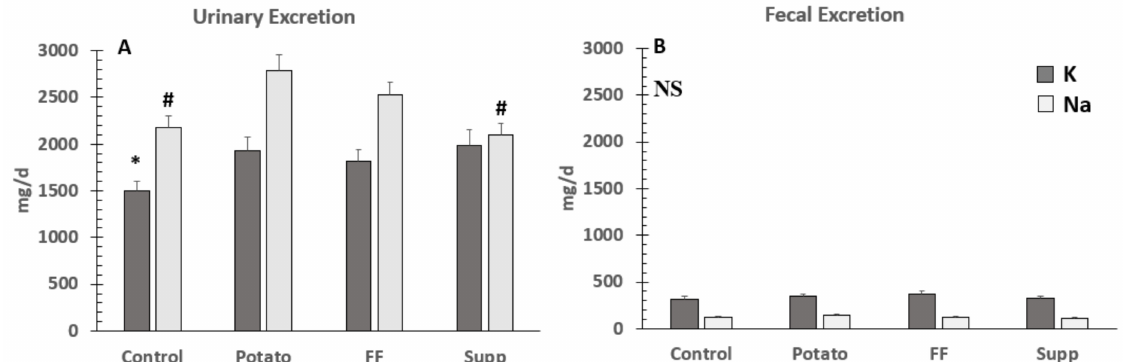
Figure 5. ( A ) Urinary (N = 28) and ( B ) Fecal (N = 20) excretion of potassium and sodium in hypertensive adults fed a typical potassium intake (control) and supplemented potassium through food (baked or boiled potatoes or French fries (FF)) or supplement. * denotes significant differences between control and potassium groups ( p < 0.05) for potassium retention. # denotes significant differences between groups for sodium retention (i.e., control and supplement were both significantly different from potato and FF, but not each other). NS, no significant differences. To convert to mmol/d for potassium, divide by 39; and for sodium, divide by